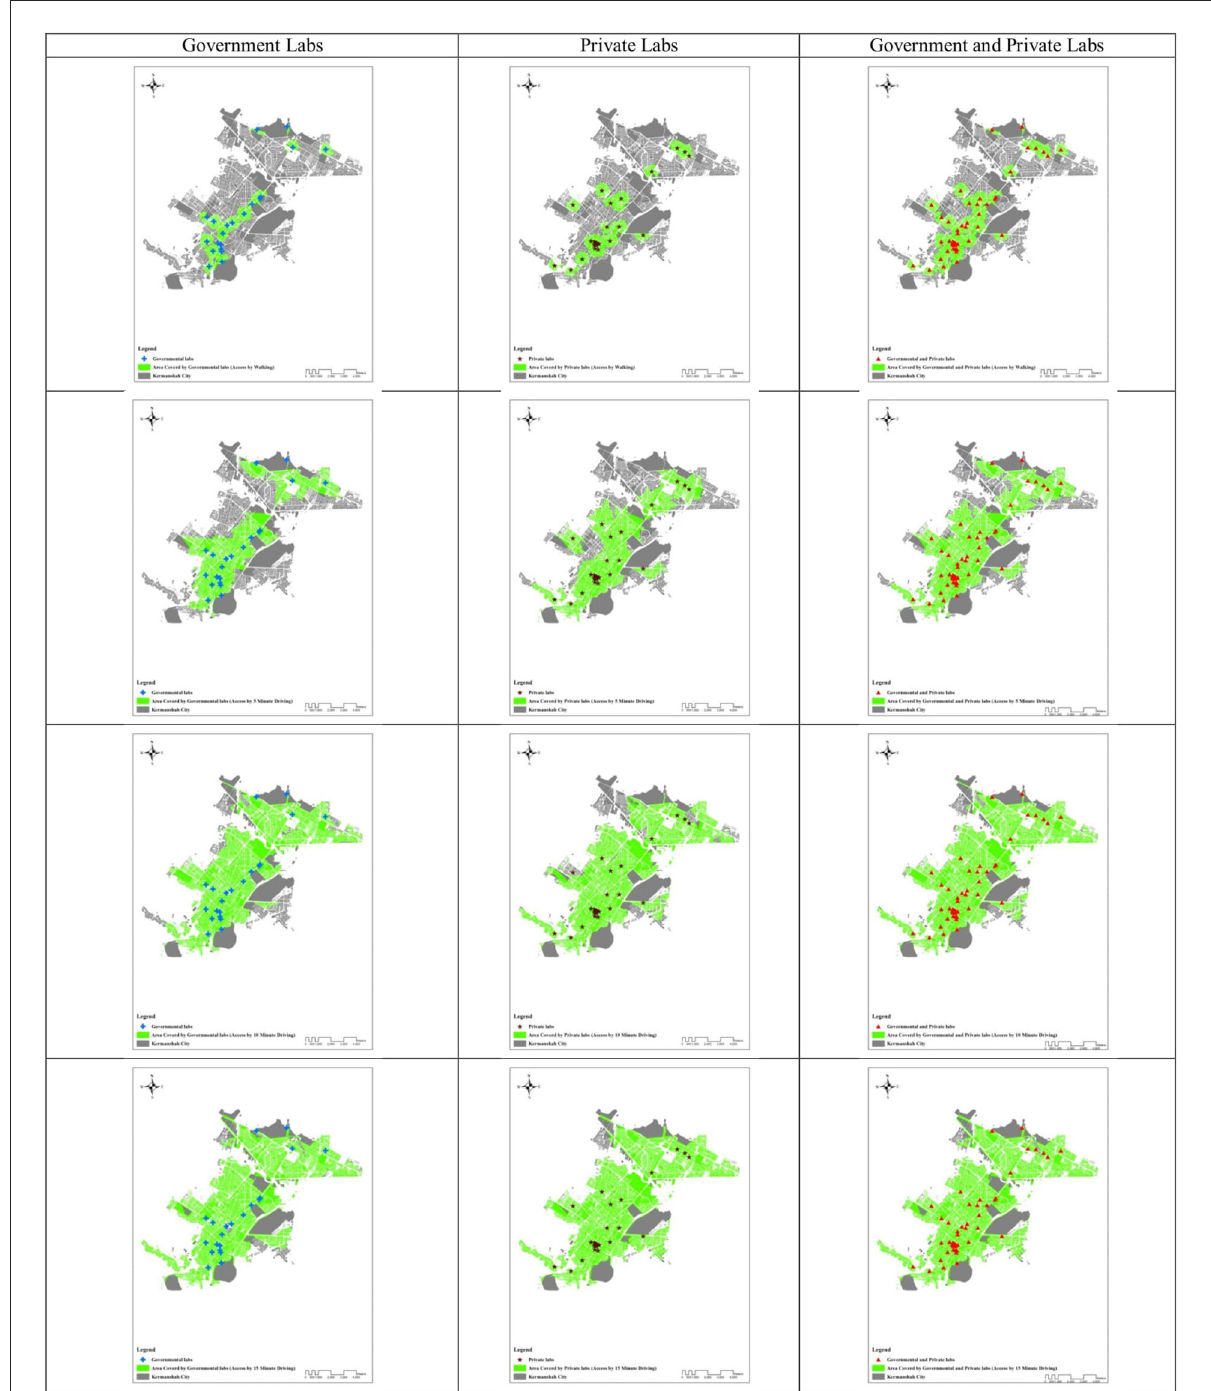
FIGURE1 Area covered by Government al and private